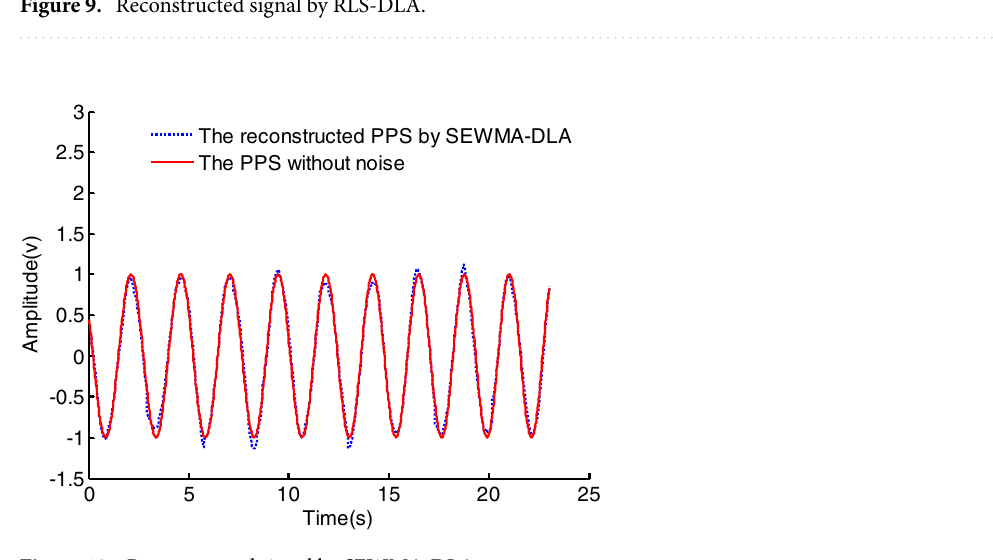
Figure 10. Reconstructed signal by